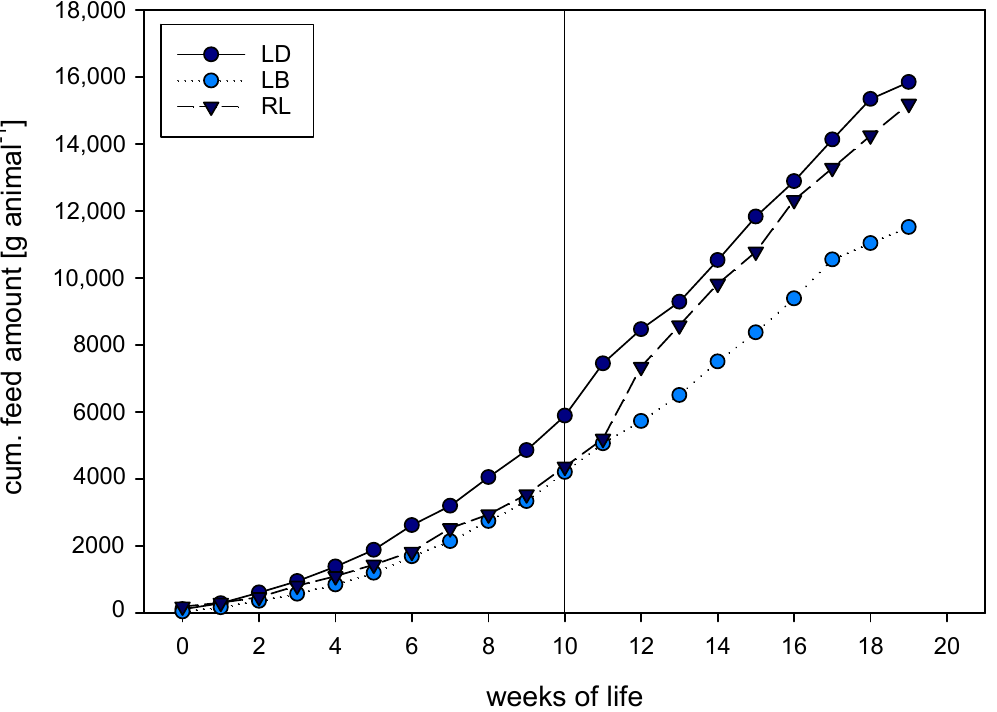
Figure 2. Cumulative feed amount in g per animal of commercial dual-purpose hybrid Lohmann Dual (LD), commercial layer hybrid Lohmann Brown (LB), and native purebred breed Rhinelander (RL) over the entire fattening period. Measures were taken from unsexed groups until week 10 (indicated for reference), when hens were removed from the flock and only 100 cocks/genotype remained. Table 1. Feed conversion ratio (FCR, feed expense ([kg bird − 1 ])/total weight gain [kg bird − 1 ]) as a measure of feed efficiency, given per genotype and week of life, in addition to average FCR per genotype. Measures were taken from unsexed groups until week 10 (indicated by line), when hens were removed from the flock and only 100 cocks/genotype remained.